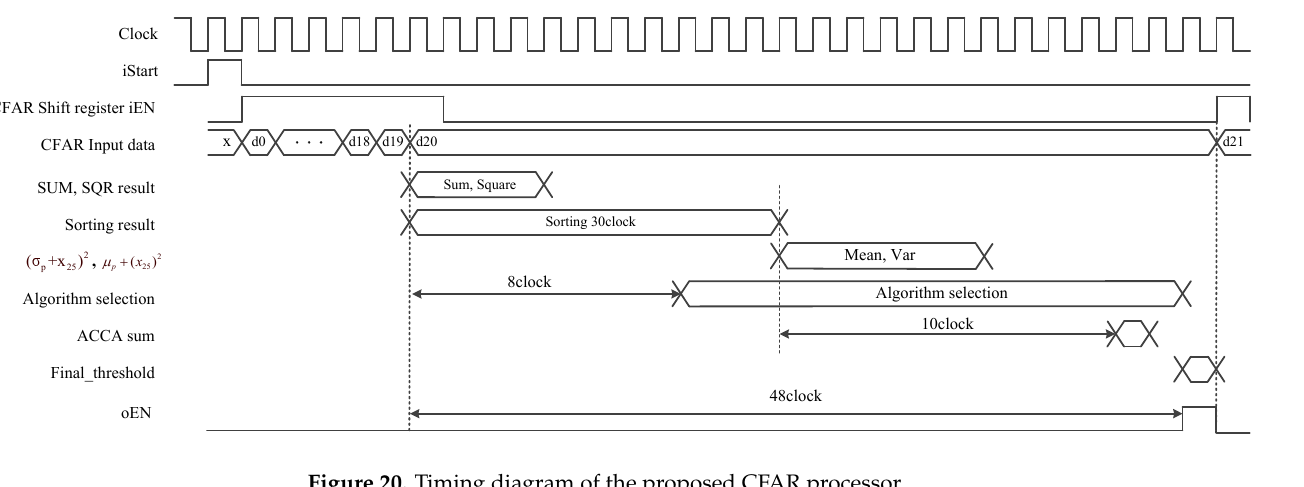
Table 4. Comparison of results between the proposed CFAR processor and the previous implementations.